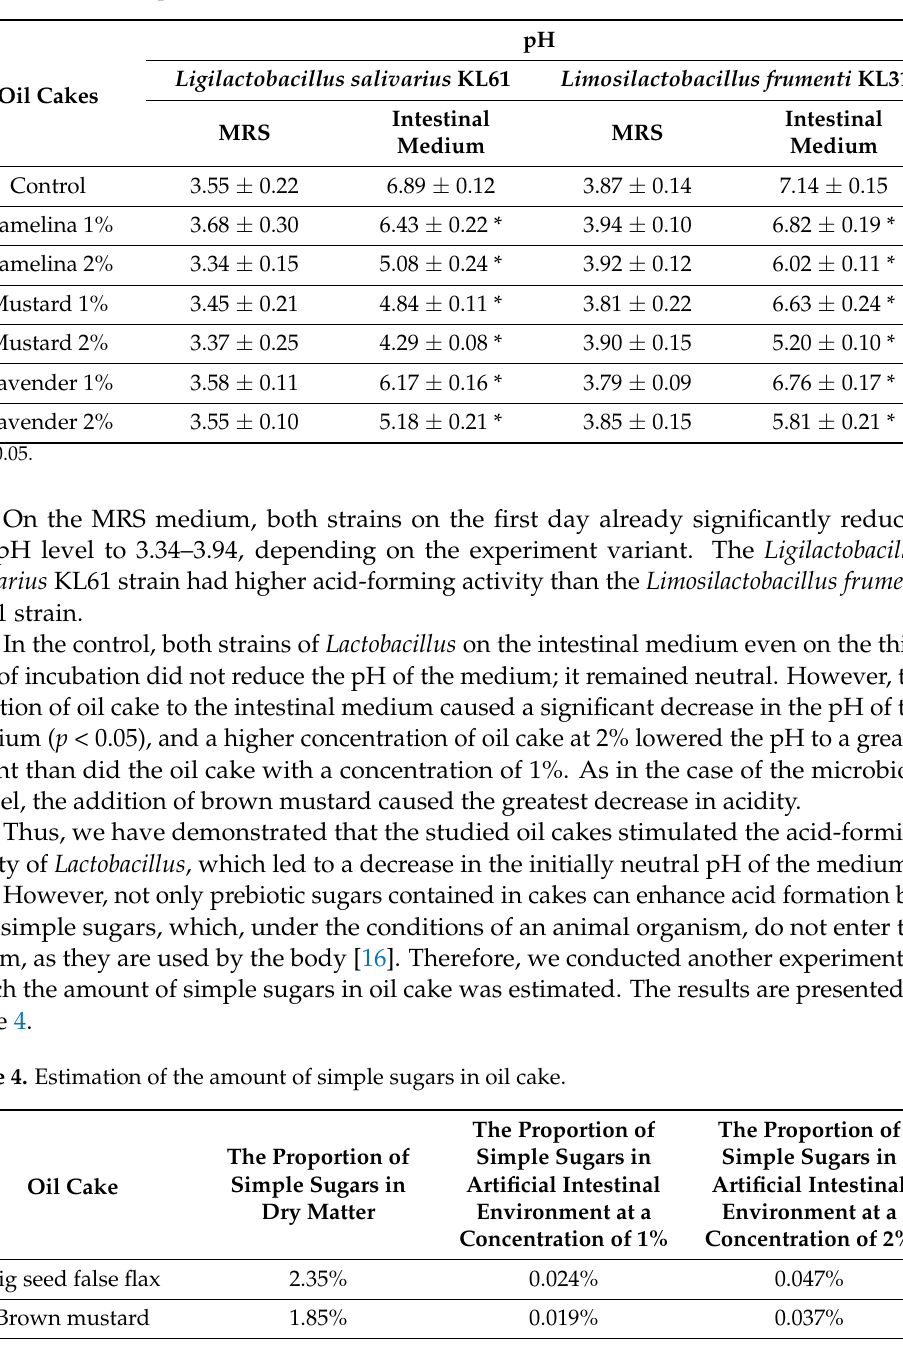
Table 3. Influence of plant oil cakes on the level of acid formation of Lactobacillus . Oil Cakes